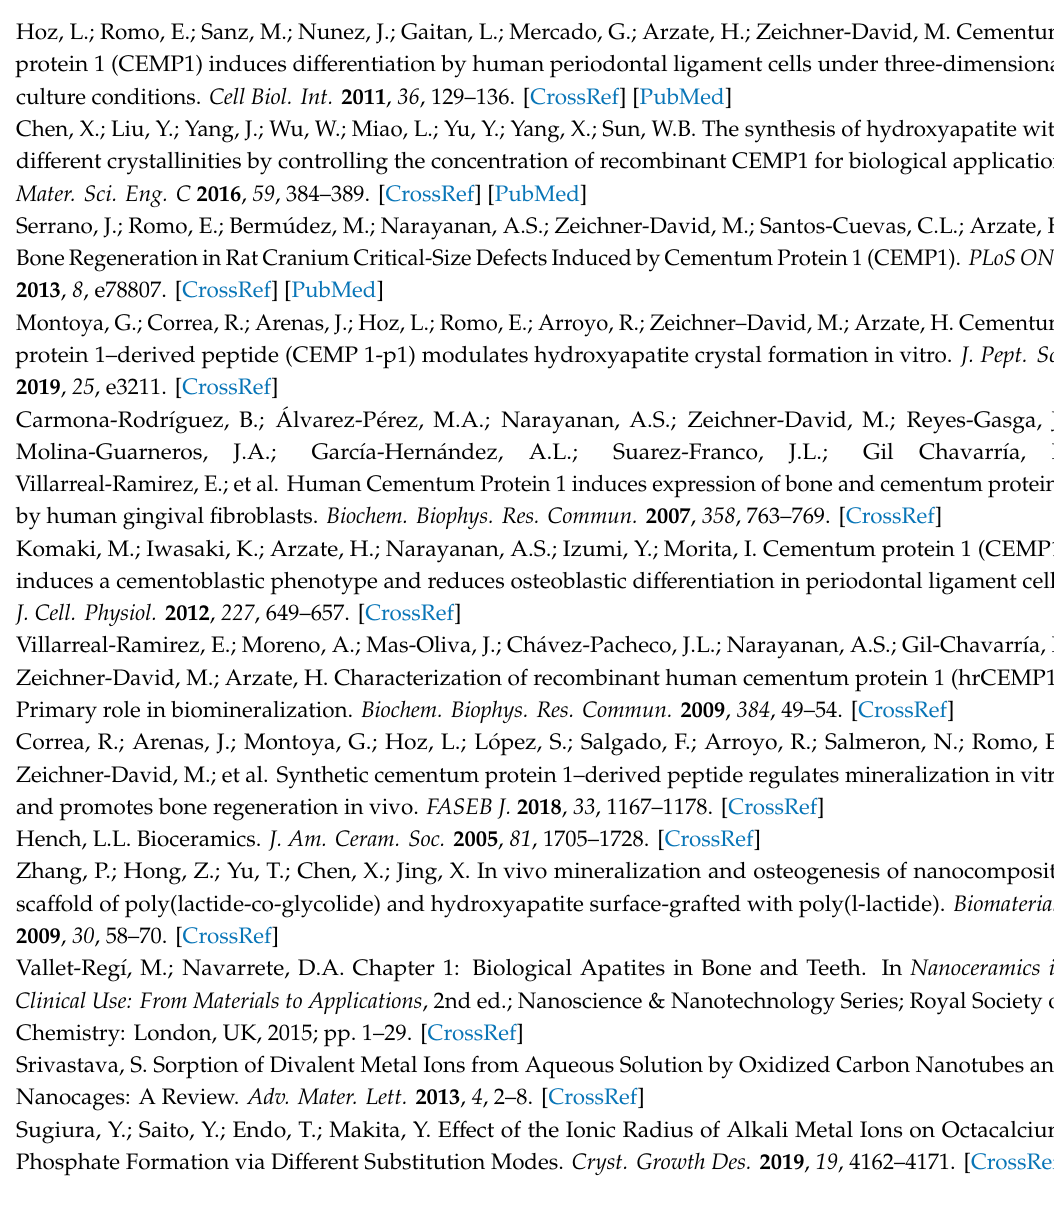
Figure S1: Crystal structure of OCP viewed along the c-axis. Figure S2: Constant Composition Seeded-Growth Assay (CCSG) of OCP in the presence of